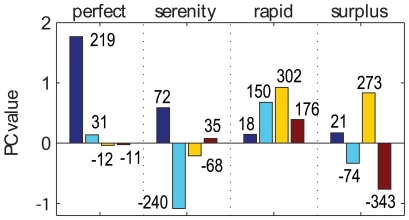
Values of the first four PCs for four different words in the MS English semantic map.PC coordinate values are represented in the bars, while the corresponding numbers express these quantities as percentages of the standard deviation of each PC (cf. Figure 2).